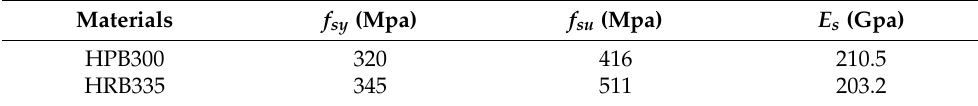
Table 4. Material properties of steel.